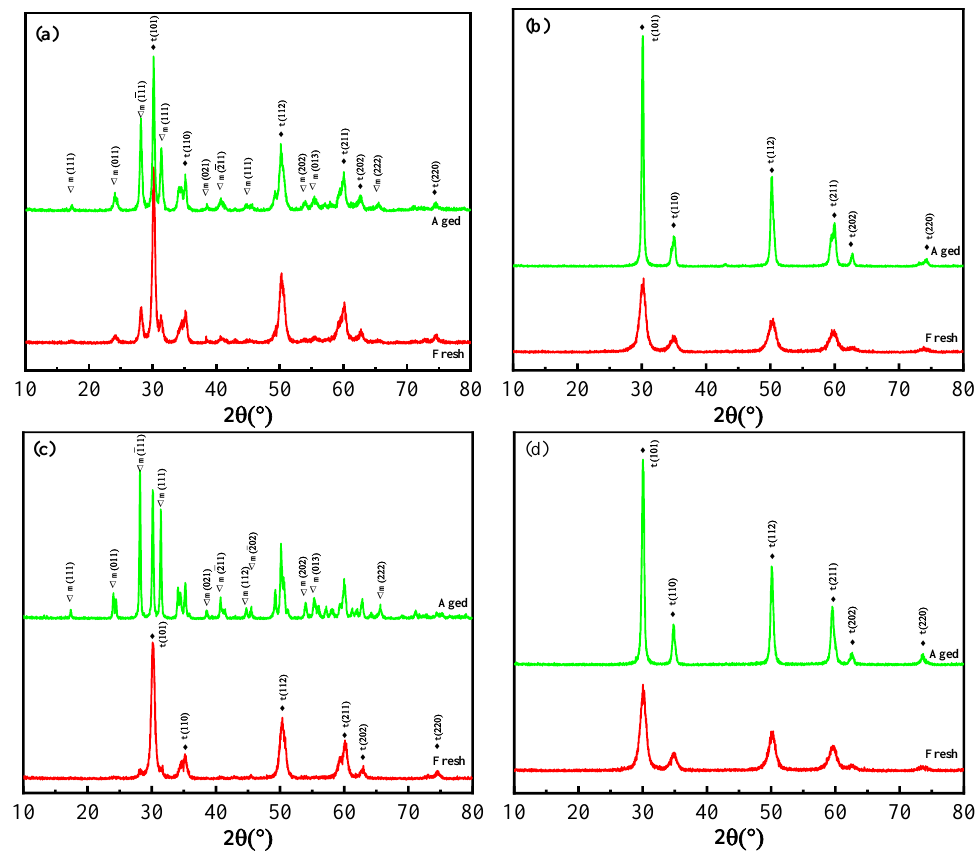
Figure 4. XRD patterns of FlYZr ( a ), SpYZr ( b ), ReYZr ( c ), and BuYZr ( d ), black rhomboid (tetragonal), white triangle (monoclinic)